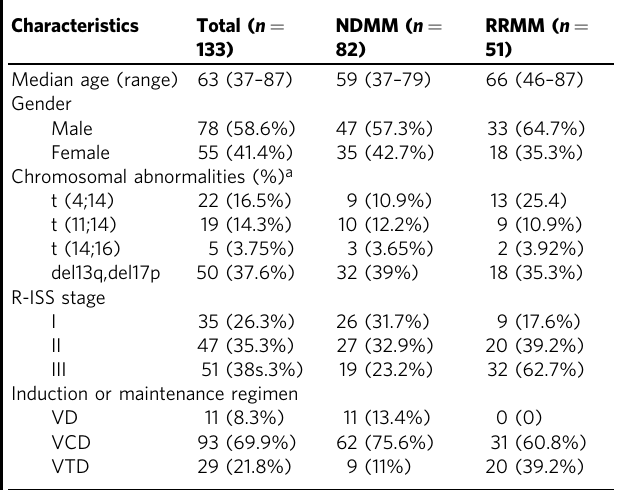
Table 1 Demographics and characteristics of patients enrolled in this